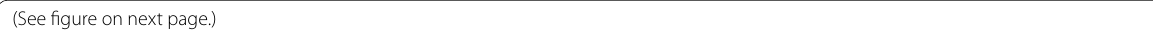
Fig. 4 Effect of bacterial treatments on growth of Vicia faba seedlings in pot experiment after 4 weeks compared to control (untreated). A seedling fresh weight; B dry weight; C shoot length; D Root length; E leaf area; F number of leaves; G internode distance; H number of branches. Duncan’s tests were used to analyze the data and the results are represented as the mean standard deviation. The presence of different letters on the bars ± indicates a significant difference between strains, whereas the presence of a common letter indicates that the strains are not significantly